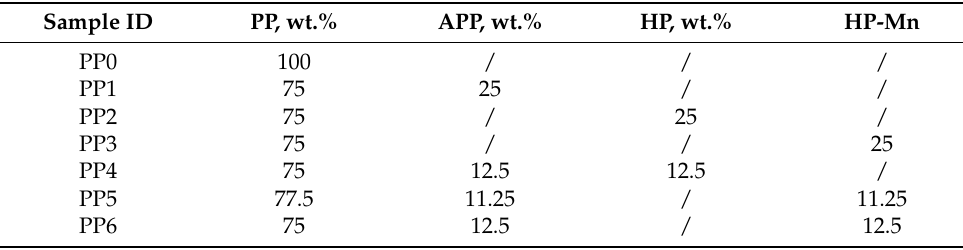
Table 1. The specific formulation of the PP/IFR